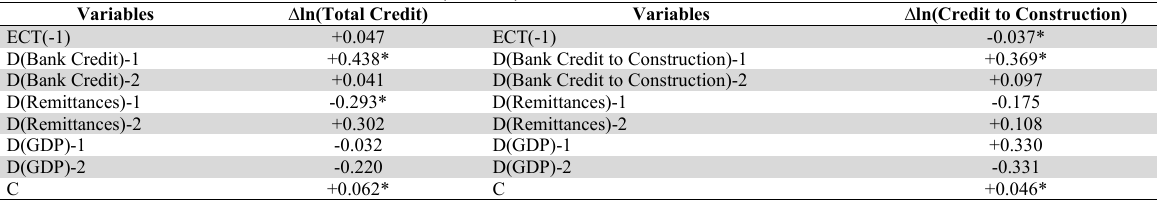
Results of the Vector Error Correction Models (VECM)